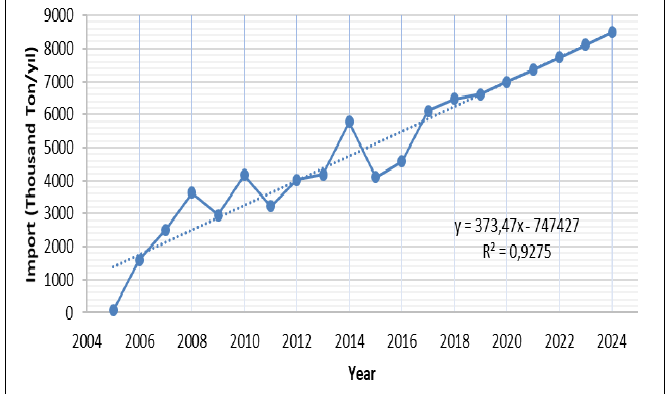
Figure 6: Wheat Import of Turkey between the years 2005-2020. Source: [23].